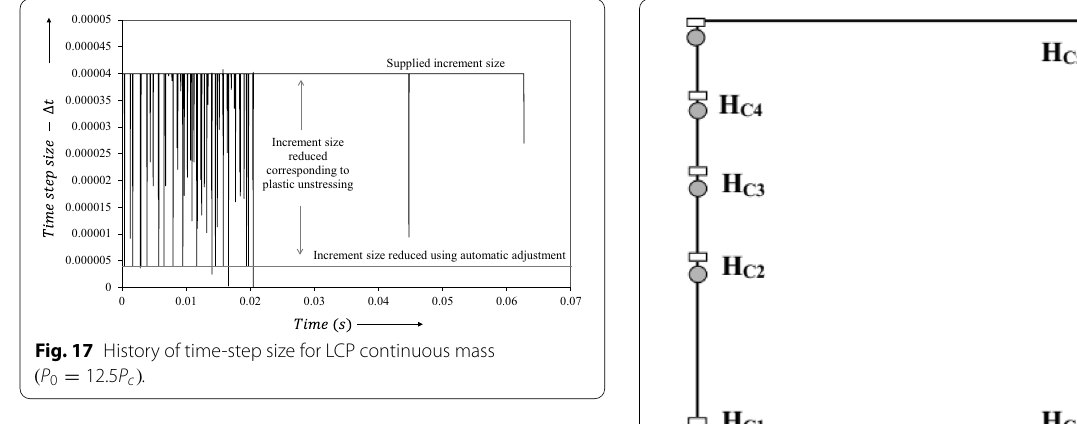
Fig. 19 Lumped mass